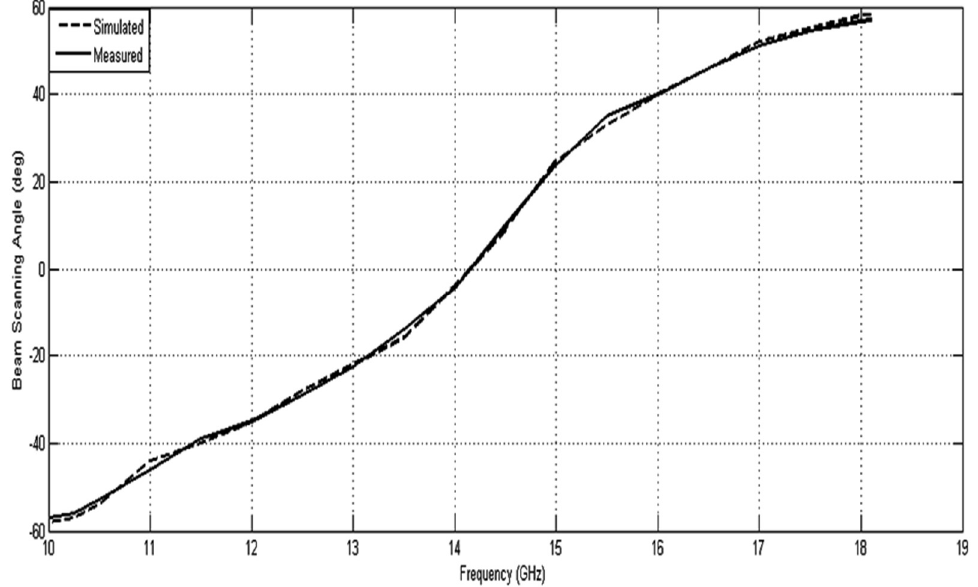
Figure 9. Radiation angles for SIW Figure 9 . Radiation angles for SIW LWA .